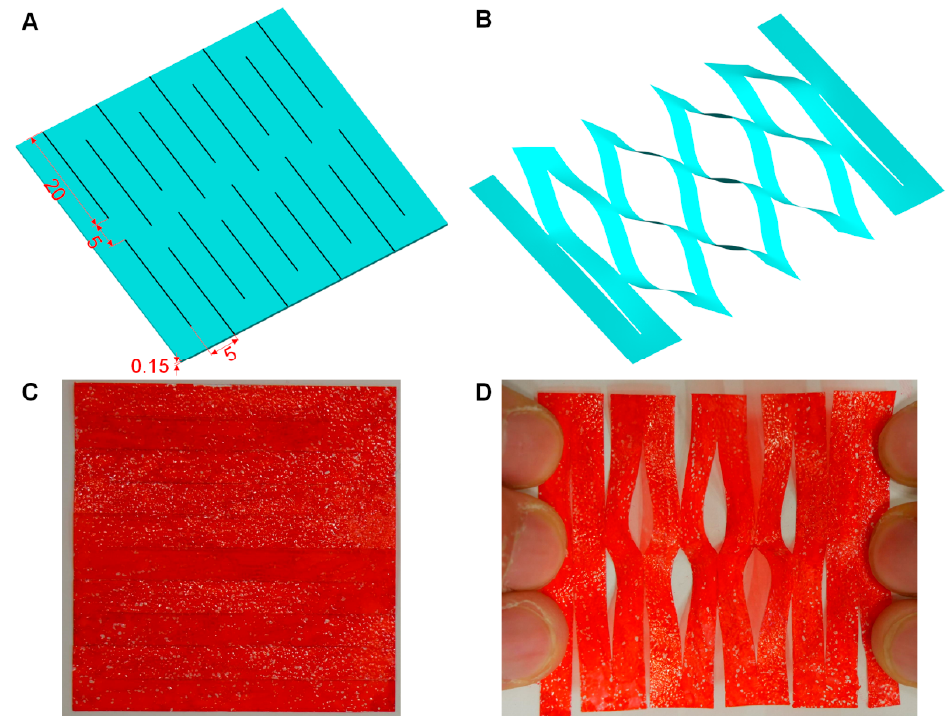
Figure 8. Kirigami structural design and prototype. ( A ) Design parameters for the kirigami structure. ( B ) Deformation into 3D (FEA model). ( C ) The prototype of the kirigami structure at rest state. ( D ) The prototype of the kirigami structure stretched by hand (The clear kirigami film is coloured red for clarity).